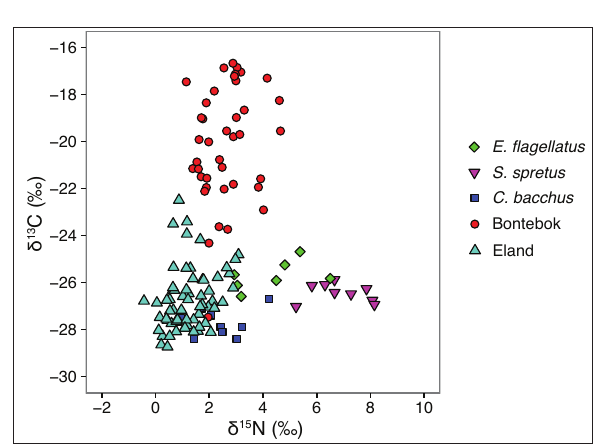
The distribution of isotopes ( δ 13 C and δ 15 N) of the dung of bontebok and eland as well as of three dung beetle species.